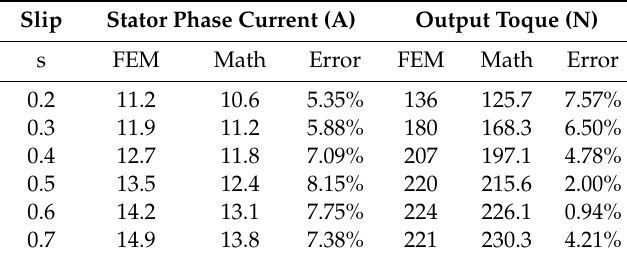
Table 5. Stator phase current and force.